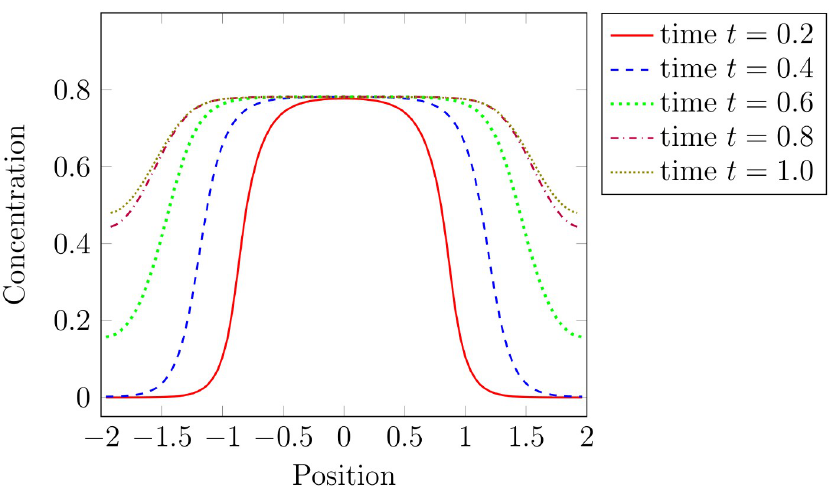
Fig 7. Time dynamics of CLV3 over-expression. Numerical calculation of CLV3 concentration for different time points after induction of ubiquitous WUS over-expression with c = 2.9: red solid for time t = 0.2, dashed blue for time t = 0.4, dotted green for time t = 0.6, dashdotted purple for time t = 0.8 and densely dotted olive time t = 1. As observed in experiments [41] the zone of high CLV3 expression extends in radial direction.